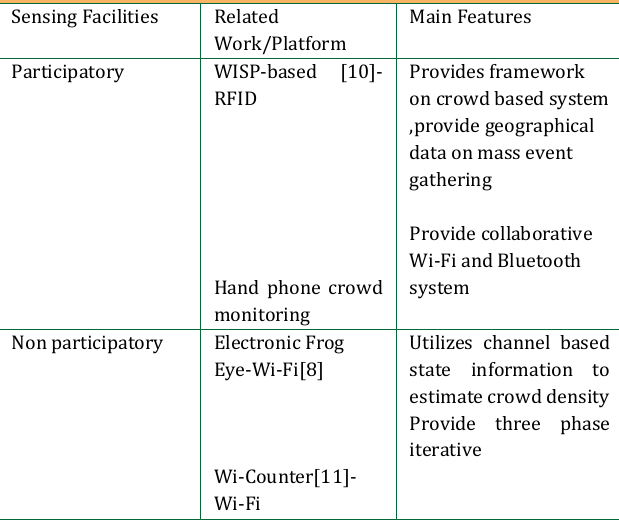
Figure 3: Block Diagram of the